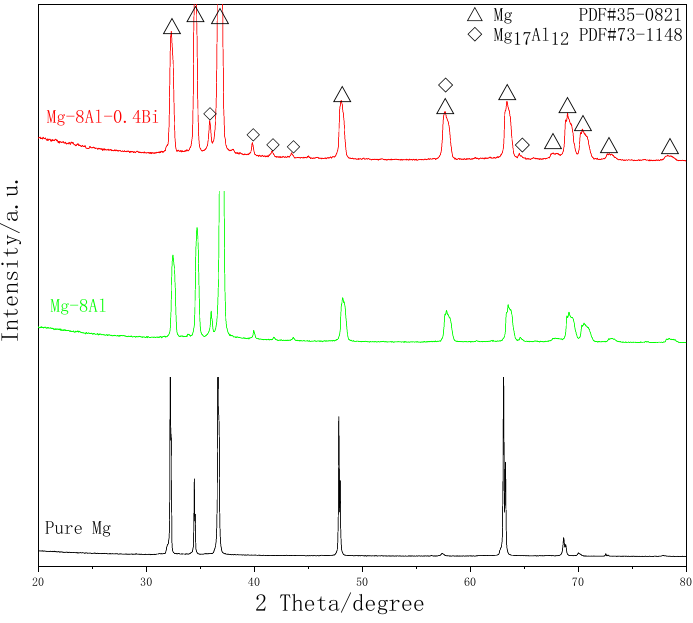
Figure 4. XRD patterns of pure Mg, Mg–8%Al, and Mg–8%Al–0.4%Bi alloy.